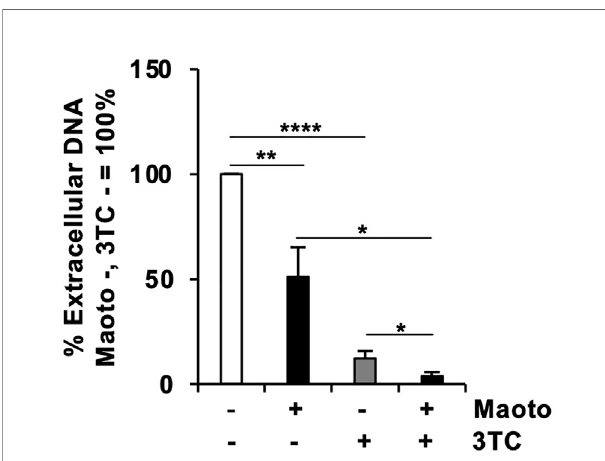
FIGURE 4 | Combined use of maoto and 3TC decreases hepatitis B virus (HBV) replication more ef fi ciently than the individual use. Cells were treated